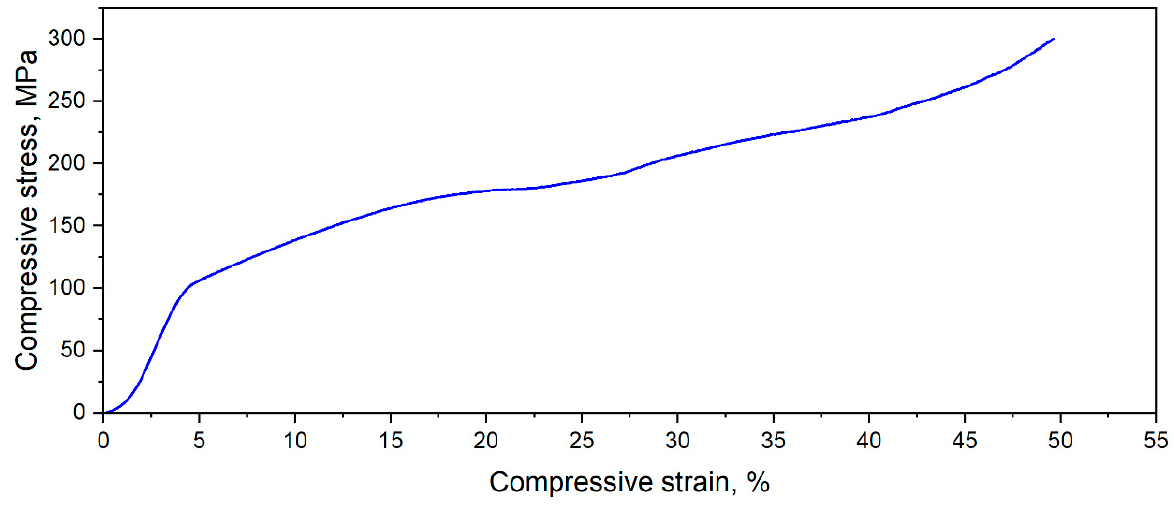
Figure 12. Stress–strain curve corresponding to compressive test applied on L-PBF-processed Mg- 10Zn-0.8Ca-0.5Zr alloy with E = 100 J/mm 3 .